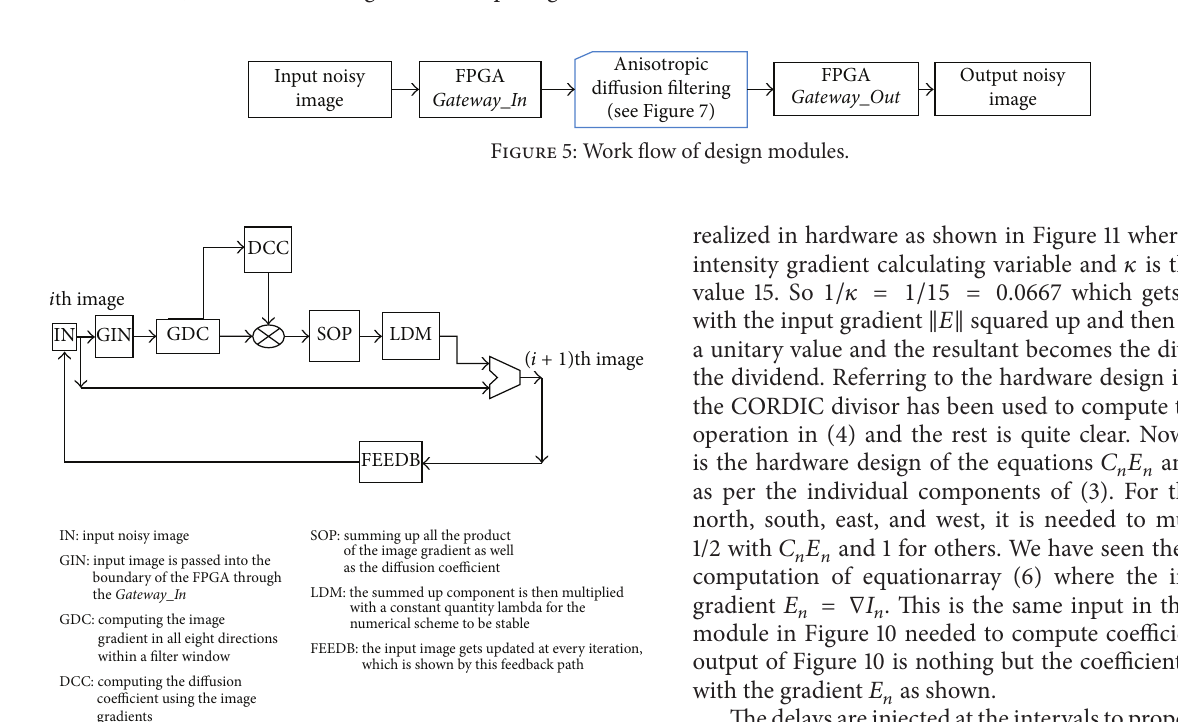
Figure 6: Work flow of design module of anisotropic diffusion filter of Figure 5 in